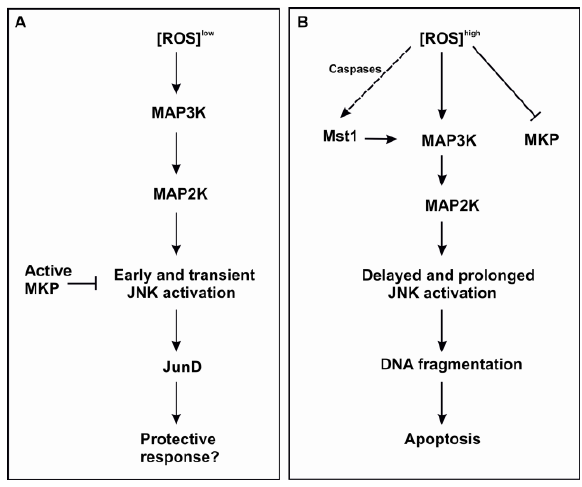
Figure 1. Hypothetical model to describe the mechanisms and outcomes of MAPK activation induced by different levels of ROS. If a pro-apoptotic stimulant induces release of ROS that is high enough to quench MKP, this may lead to prolonged JNK activation and apoptosis ( B ); Low levels of ROS may lead to transient activation of JNK due to presence of active MKP and end up in a protective response ( A ). The specific pathway mediating activation of Mst1 is unclear. ROS, reactive oxygen species; MAP3K, mitogen-activated protein kinase kinase kinase; MAP2K, mitogen-activated protein kinase kinase; JNK, c-Jun N -terminal kinase; MKP, MAP kinase phosphatase; Mst1, mammalian sterile 20-like kinase